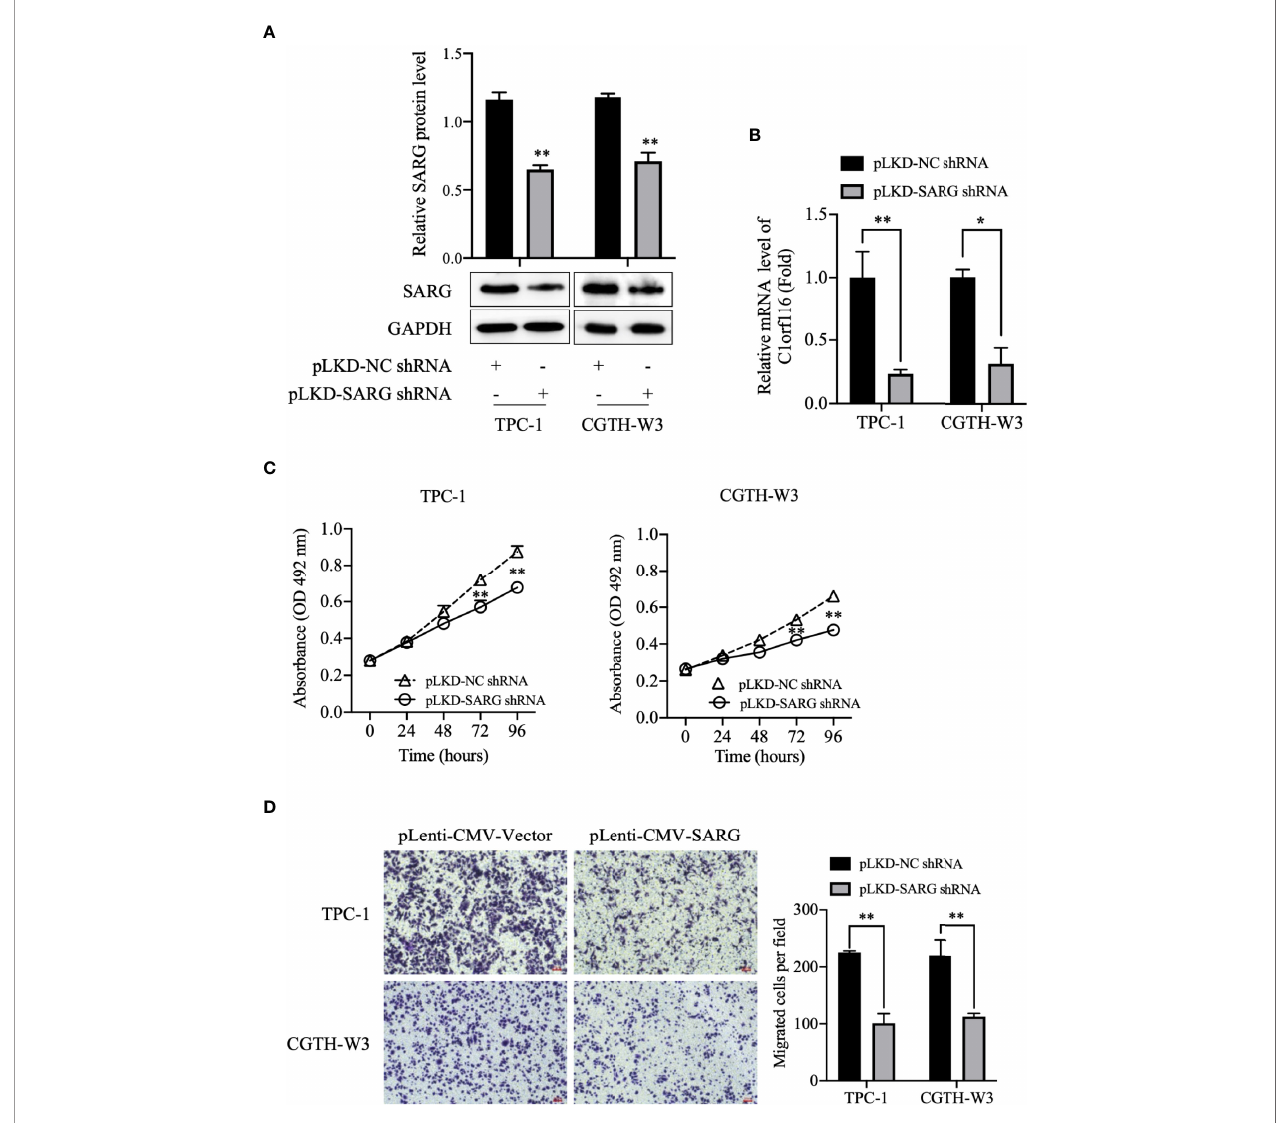
FIGURE 4 | SARG knockdown impaired PTC cells proliferation and migration. (A) SARG protein expression in TPC-1 and CGTH-W3 cells was signi fi cantly decreased after being transfected with SARG-shRNA. GAPDH was used as a loading control, whereas NC-shRNA was used as the negative control. (B) SARG knockdown ef fi ciency was evaluated by reverse transcription-quantitative PCR, with all expression levels normalized to those of GAPDH. Data are presented as fold changes relative to the SARG levels in control cells. (C) SARG knockdown could reduce TPC-1 and CGTH-W3 cells proliferation. (D) SARG knockdown inhibited TPC-1 and CGTH-W3 cells migration in transwell assay. SARG, speci fi cally androgen-regulated gene. *, p<0.05, **, p<0.01 compared with NC